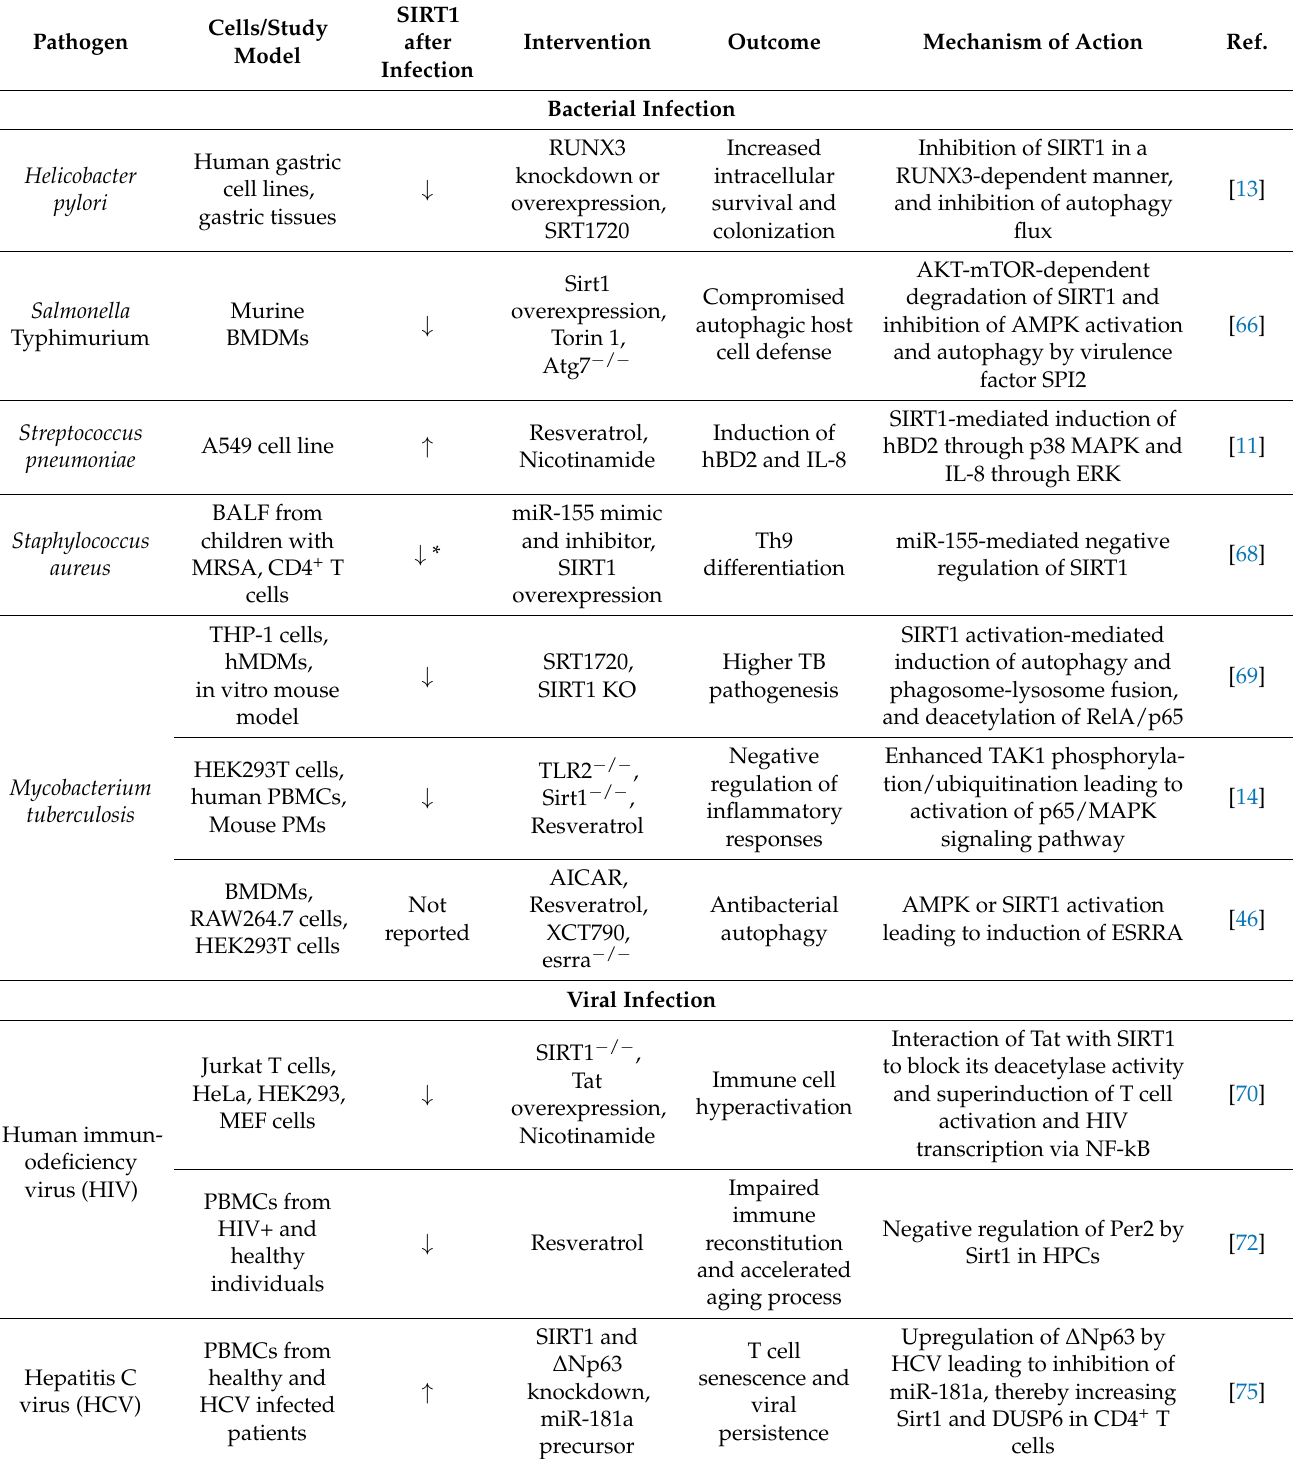
Table 1. Roles of SIRT1 during bacterial, viral, and parasitic